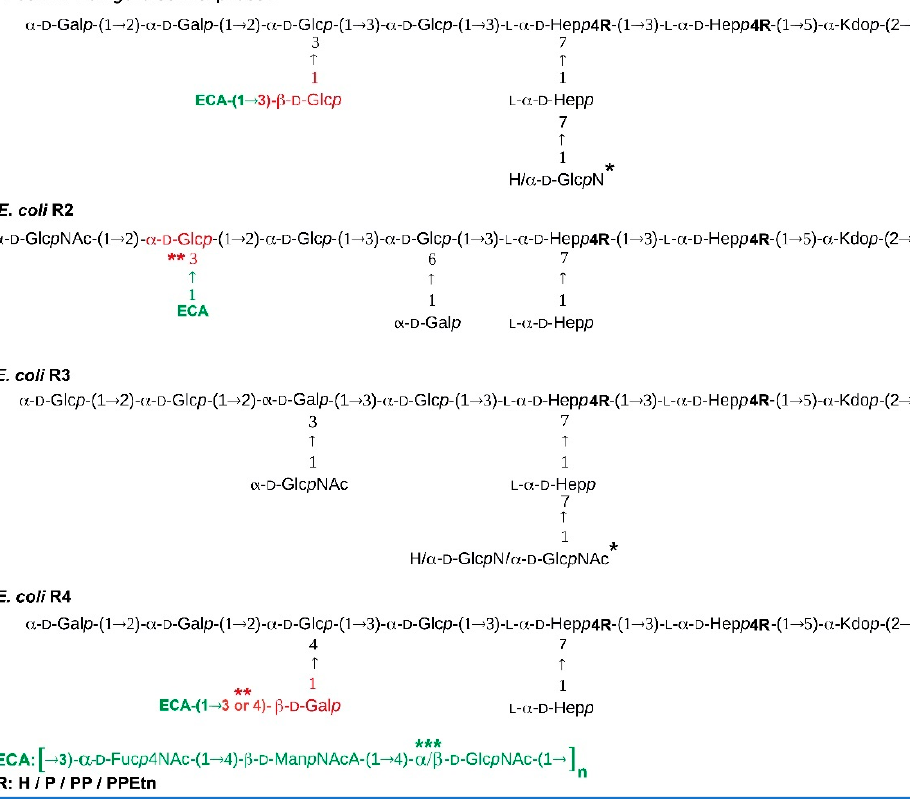
Figure 1. Structures of the core oligosaccharides (OS) and [ECA]-core OS in S. sonnei phase II and E. coli R1, R2, R3, and R4 lipooligosaccharides (LOS). The ECA stands for enterobacterial common antigen. The sugar residue of the ligation between core OS and ECA is colored in red. The ECA repeating unit is colored in green. R stands for nonstoichiometric substituents, such as a phosphate group (P), a pyrophosphate group (PP), pyrophosphorylethanolamine (PPEtn). The symbol * indicates heterogeneity of the core OS regarding terminal sugar residues. Symbol ** indicates ECA ligation sites assumed by the mass spectrometry only. Symbol *** indicates an inverted anomeric configuration of the D-Glc p NAc in the first ECA unit linked to the core OS, whereas an α -configuration is characteristic for the polymeric chain. The R1, R2, R3, and R4 core OS structures are presented according to published data [9–11].